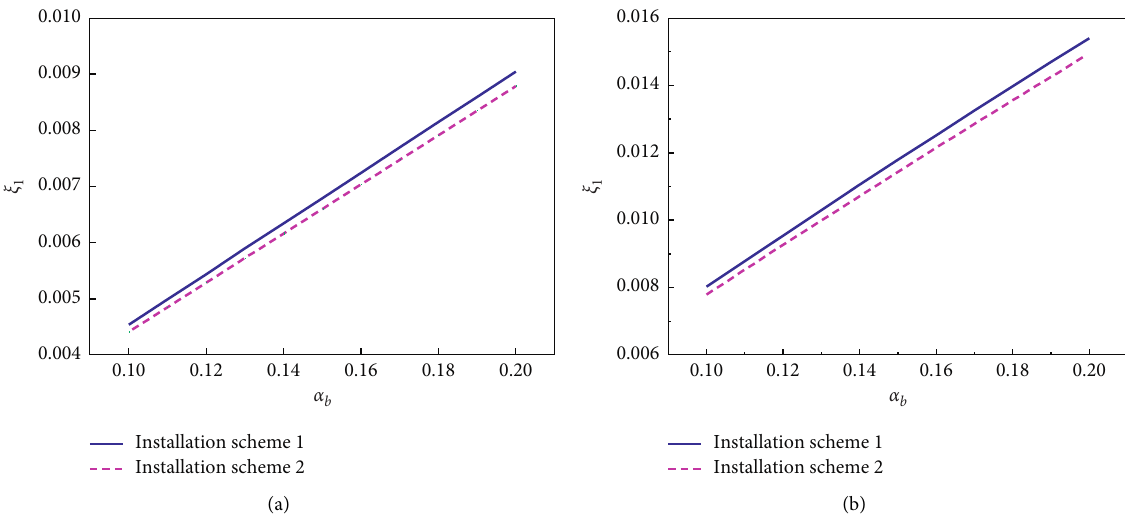
1 with α b under two installation schemes: (a) the modal strain energy